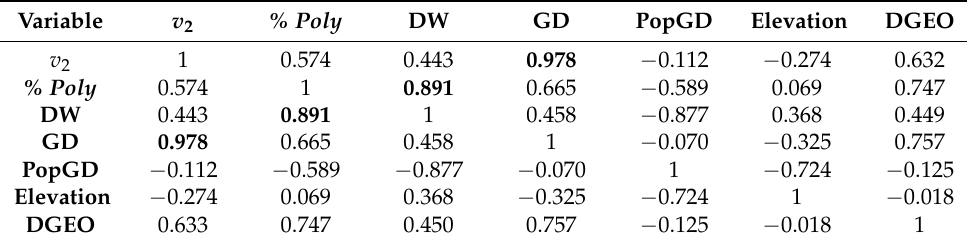
Table 3. Significant and non-significant correlations between genetic and geographic variants of Pinus cembroides and the different peripheral and central populations of this